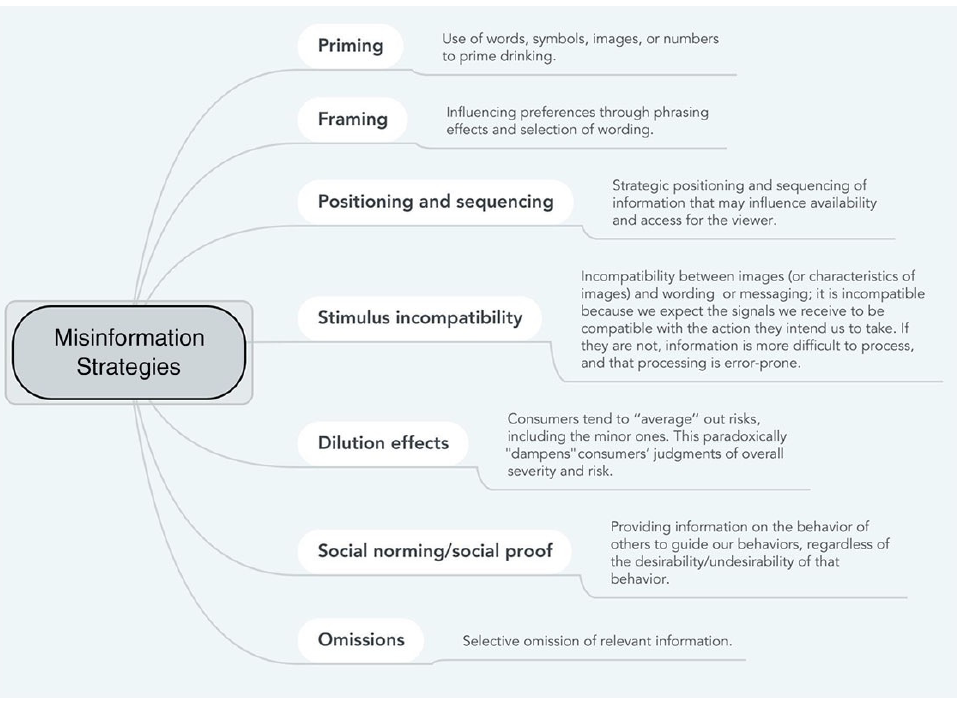
Figure 1. Misinformation Dark Nudges and Sludge Found in This Study (Petticrew et al., 2020) [55]. (Reprinted from Ref. [55]).